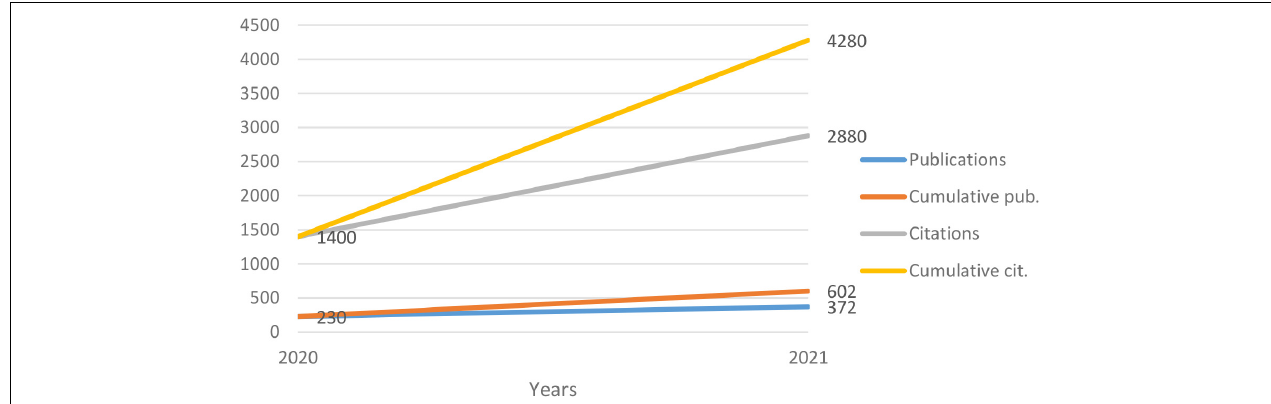
FIGURE 1 | Publications per year (KnowledgeMatrix Plus